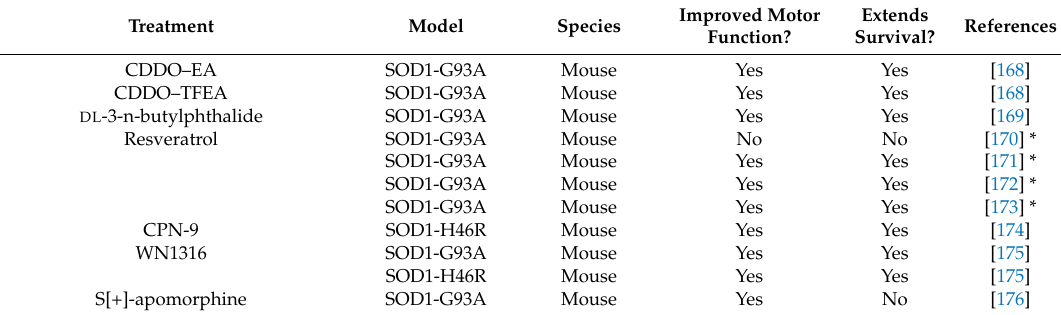
Table 5. Preclinical studies on Nrf2 activation in animal models of amyotrophic lateral sclerosis. Treatment Model Species